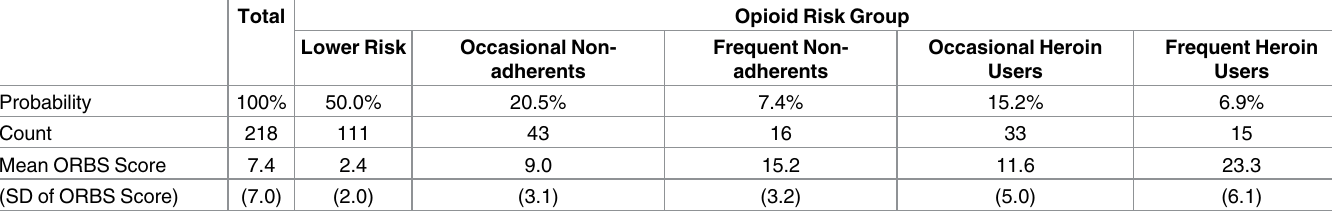
Table 3. Five opioid overdose risk groups among veterans(Latent Class Analysis). Total Opioid Risk Group Lower Risk Occasional Non- Frequent Non- Occasional Heroin Frequent Heroin adherents adherents Users